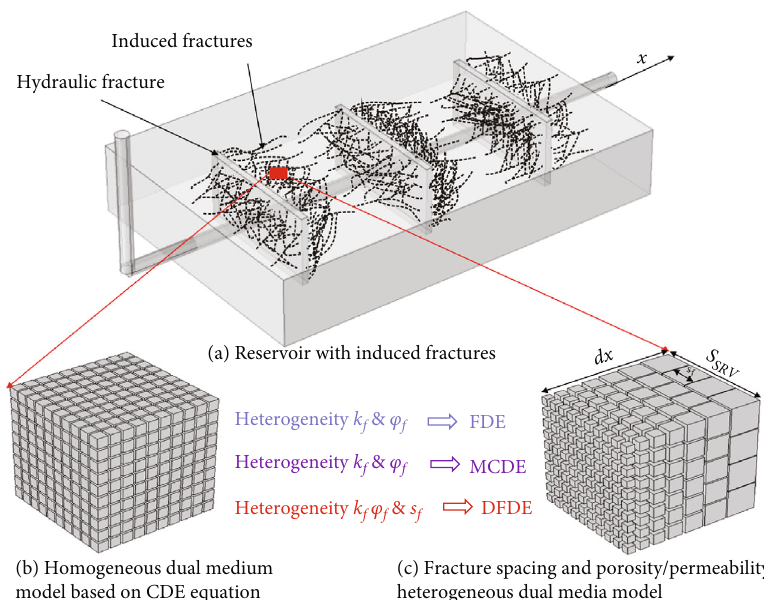
Figure 5: Governing equations for fl uid fl ow in multiple media [44].